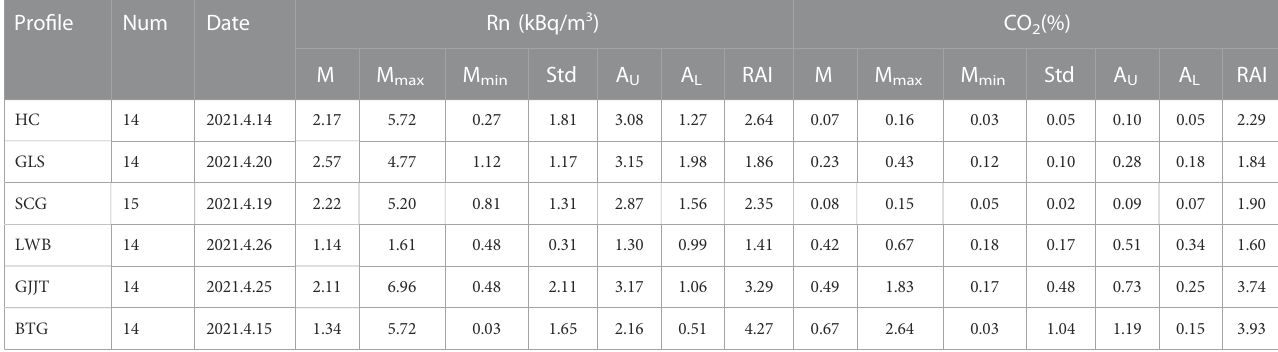
TABLE 4 Observed results of the soil gas Rn and CO 2 in the 6 survey pro fi les in the Yellow River Fault zone. Pro fi le